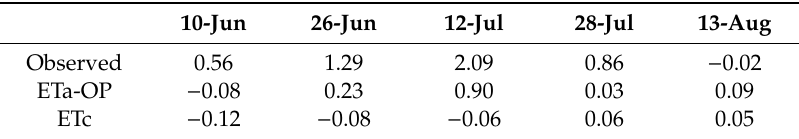
Table 2. Average di ff erence in daily ET (mm day − 1 ) between southern and northern portions of the vineyard for Observed, ET a -OP and ET c